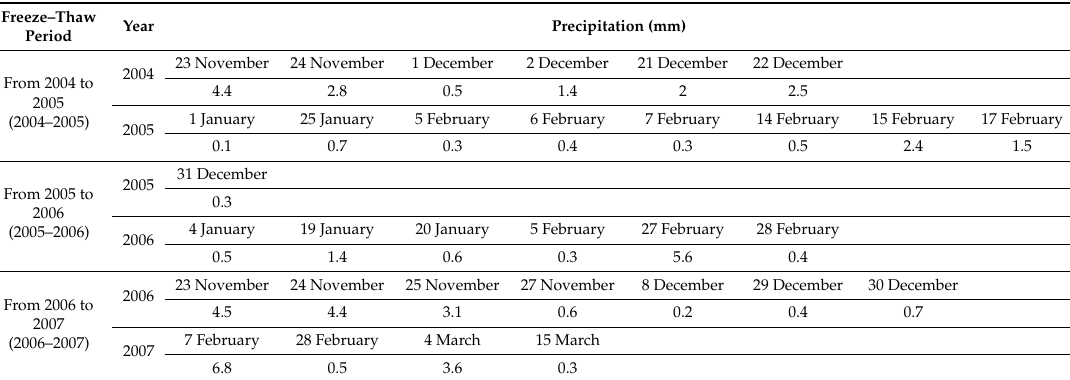
Figure 1. Average daily air temperature and solar radiation during the three successive freeze–thaw periods ( a ) from November 2004 to March 2005; ( b ) from November 2005 to March 2006; and ( c ) from November 2006 to March 2007. Table 1. Precipitation during freeze–thaw